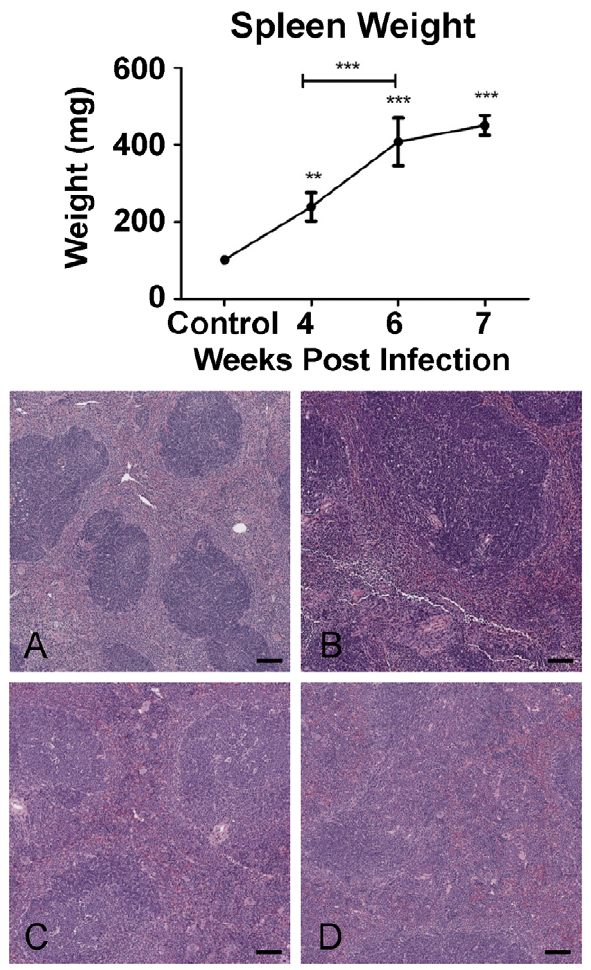
Figure 1. Splenic pathology induced by schistosome infection. Upper panel: Spleen weight increased over time following S. japonicum infection reaching approximately 4.5 times that of controls at 7 weeks p.i. The graph represents mean spleen weight of mice pooled for microarray analysis 6 1SD (n=4 per group). Lower panel: Schistosome induced splenomegaly was associated with increasing congestion of the red pulp and loss of definition between the red (lighter staining) and white pulp (darker staining) over time A: Control; B: 4 weeks p.i.; C: 6 weeks p.i.; D:7 weeks p.i. (Haematoxylin and eosin 6 40; Bar equals 100 m